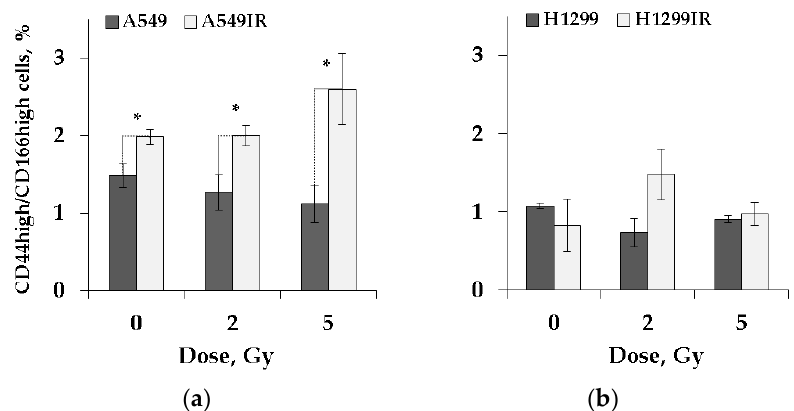
Figure 5. Evaluation of CD44high/CD166high (CSC-like) population in parental and MFR-surviving sublines. The pro- portion of CD44high/CD166high population in A549 and A549IR cells ( a ) and H1299 and H1299IR cells ( b ). Data are means ± SD of three independent experiments. * p <